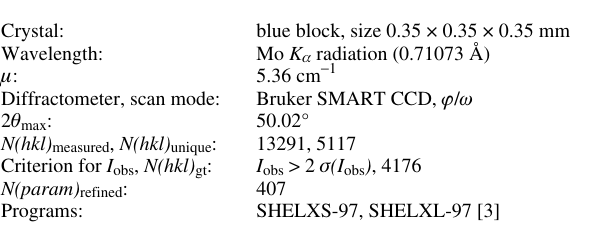
Table 1. Data collection and